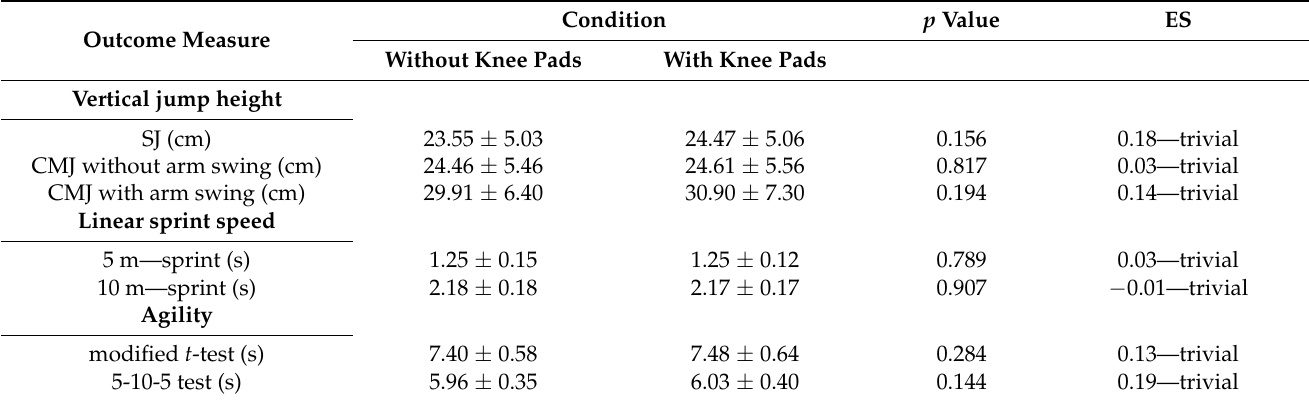
Table 2. Differences and effect size values between the